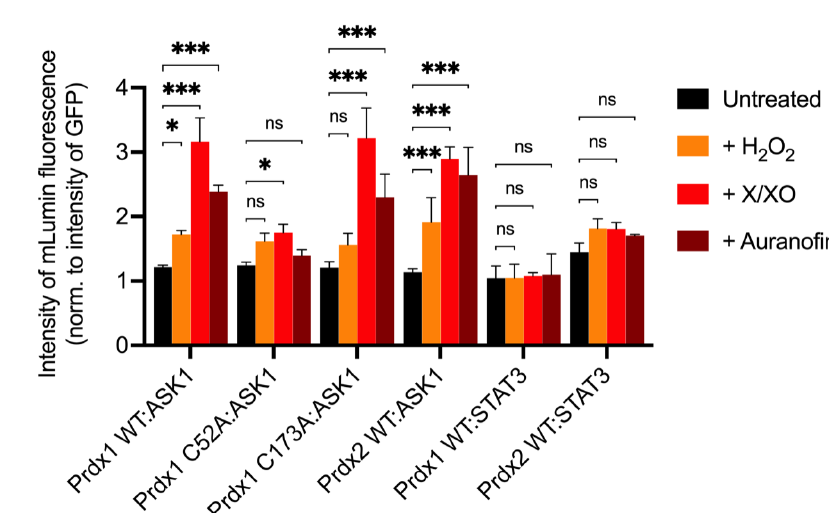
Figure 5. Prdx1 (WT, C52A, and C173A) and Prdx2 WT interact with ASK1 independently of AnxA2. The fluorescent signal (red dots) emitted by the mLumin protein upon proteins complementation in AnxA2 KO HEK293 MSR cells (i.e., the interaction of the ASK1-LN with Prdx1-LC) is shown. BiFC signal upon ( A ) Prdx1 WT:ASK1, ( B ) Prdx1 C52A:ASK1, ( C ) Prdx1 C173A:ASK1, ( D ) Prdx2 WT:ASK1, ( E ) Prdx1 WT:STAT3, and ( F ) Prdx2 WT:STAT3 interaction. The treatments from left to right were: no treatment, 100 µ M H 2 O 2 for 30 min, X/XO (8 µ M X and 1 mU/mL XO) for 18 h, and 0.8 µ M auranofin for 18 h. ( G ) Quantified mLumin/GFP values in AnxA2 KO HEK293 MSR cells; Prdx1 WT:STAT3 and Prdx2 WT:STAT3 were the controls. All images were captured with the total magnification of 100 × . The GFP images used for normalization are presented in Figure S7. The results are representative of n = 3 independent experiments. All bar charts in this figure represent the mean ± SD. * p ≤ 0.05; *** p ≤ 0.001; ns not significant; based on an unpaired ANOVA